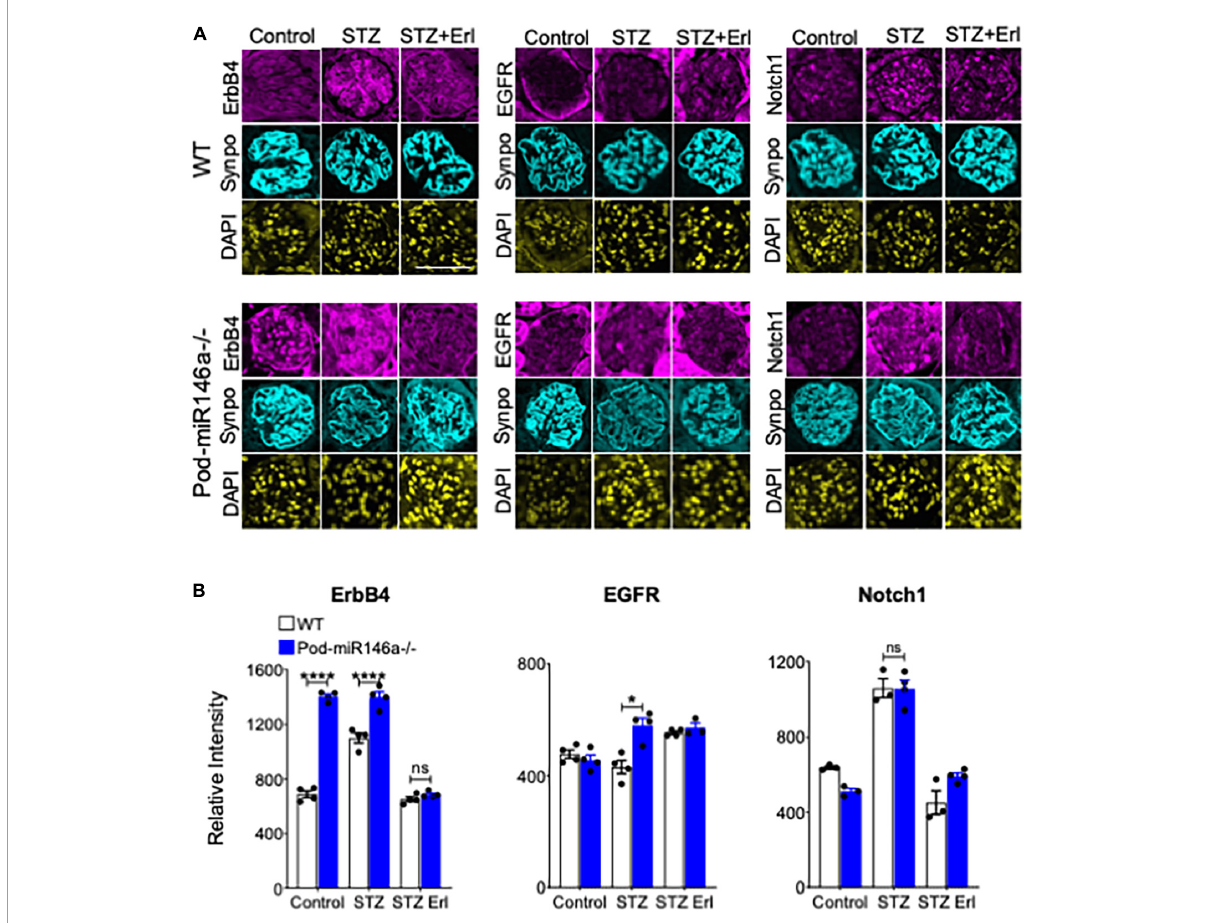
FIGURE5 Immunofluorescence imaging-based analyses of glomerular sections shows erlotinib administration protects WT and Pod-miR-146a − / − mice from STZ injury via reduction in ErbB4 and EGFR. (A) Representative confocal microscopy images of immunofluorescently labeled glomeruli from WT (top three panels) and Pod-miR146a (bottom three panels) mice treated with vehicle alone (Control), with STZ and vehicle (STZ) or with STZ and erlotinib (STZ Erl). Tissue sections were imaged after staining with DAPI (nuclear marker) and antibodies against ErbB4, EGFR, Notch-1 and Synaptopodin (Synpo, podocyte marker) (as indicated). Scale bar, 50 µ m. (B) Bar graphs showing quantification of relative glomerular signal intensity of ErbB4, EGFR and Notch-1 in tissue samples from A. Statistics were performed using two-way ANOVA. Data